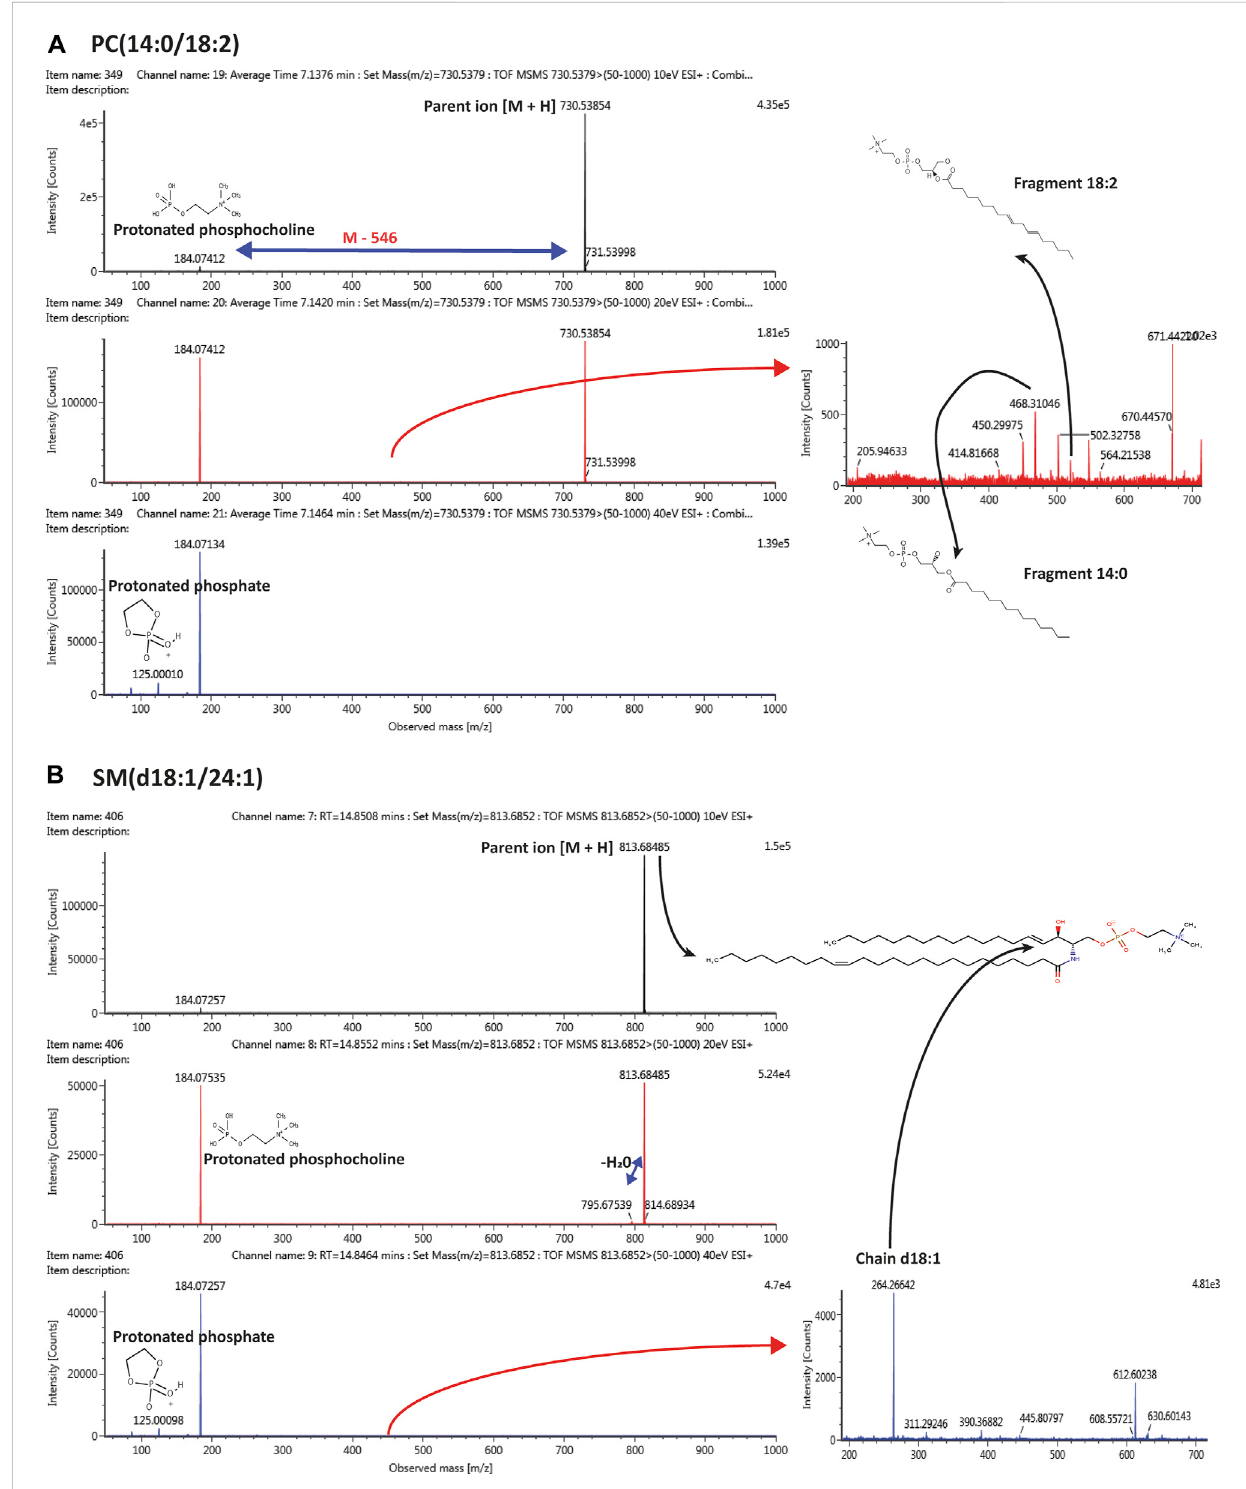
FIGURE 7 Tandemmassspectrometry(MS/MS)representingthepatternoffragmentationwith10,20,40 eVinESI(+)mode,leadingtotheidenti fi cationof